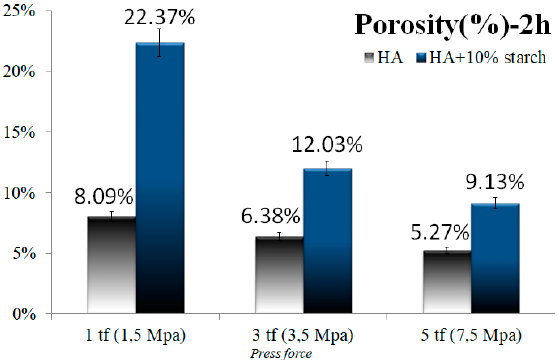
Figure 1. Determination of porosity at 2 h sintering maintenance